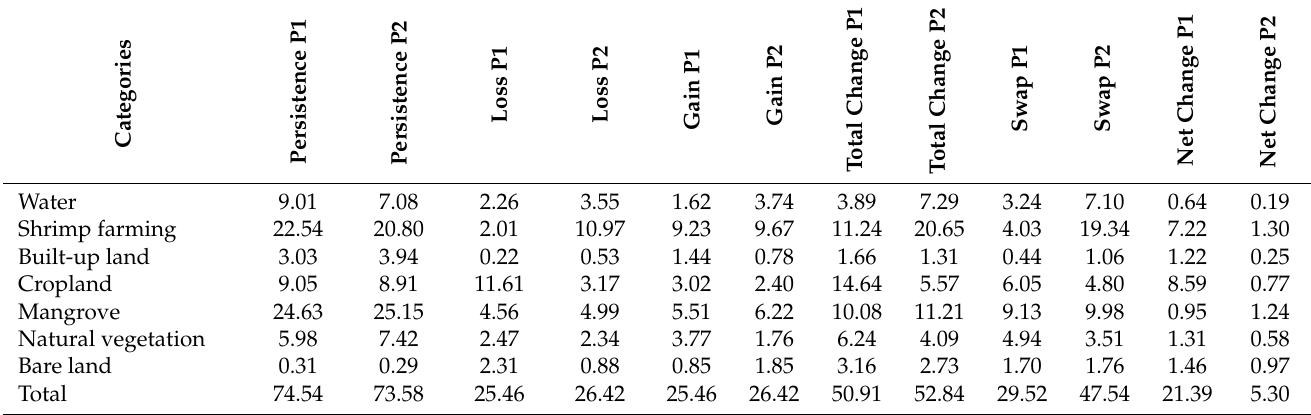
Table 7. Indicators of change in the different land use categories *.